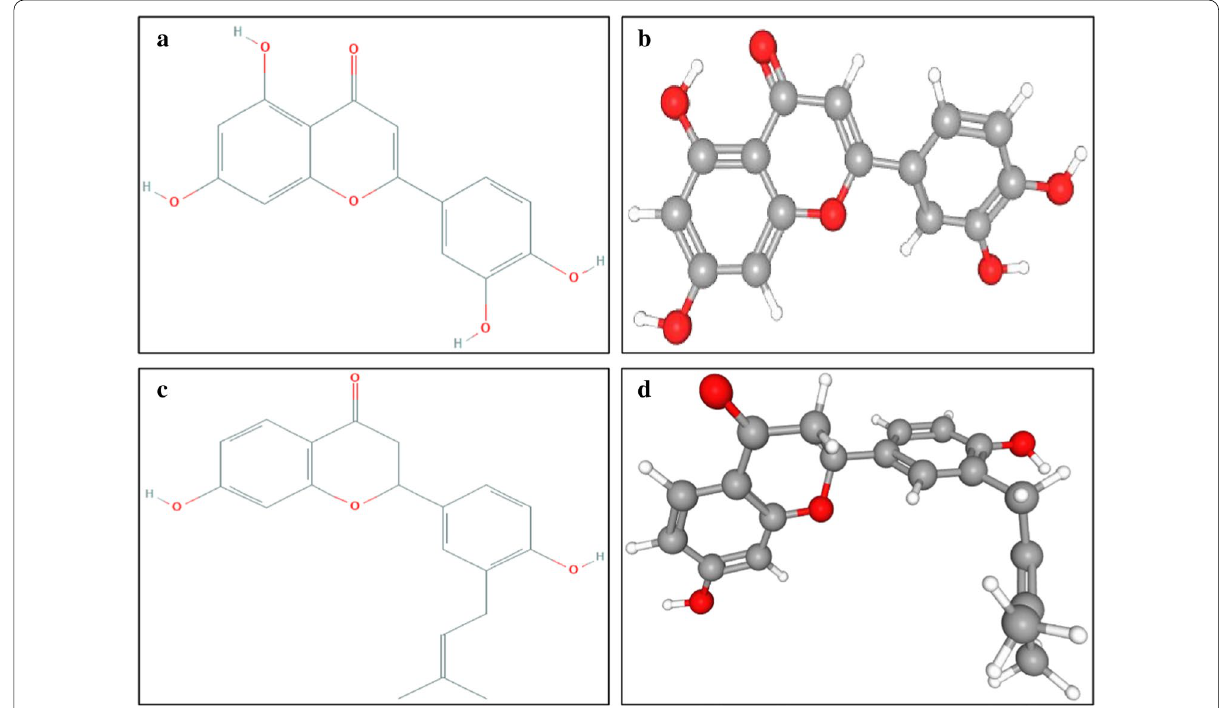
Fig. 2 a 2D structure of C3/luteolin, b 3D structure of C3/luteolin, c 2D structure of C43/abyssinone II and d 3D structure of C43/abyssinone